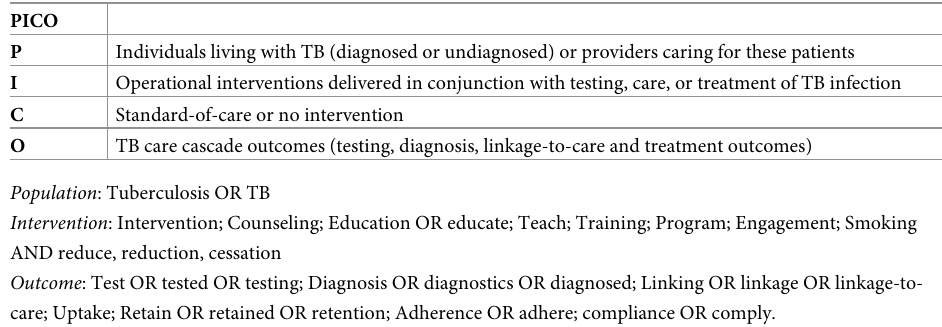
Table 1. Detail of PICO components that informed search